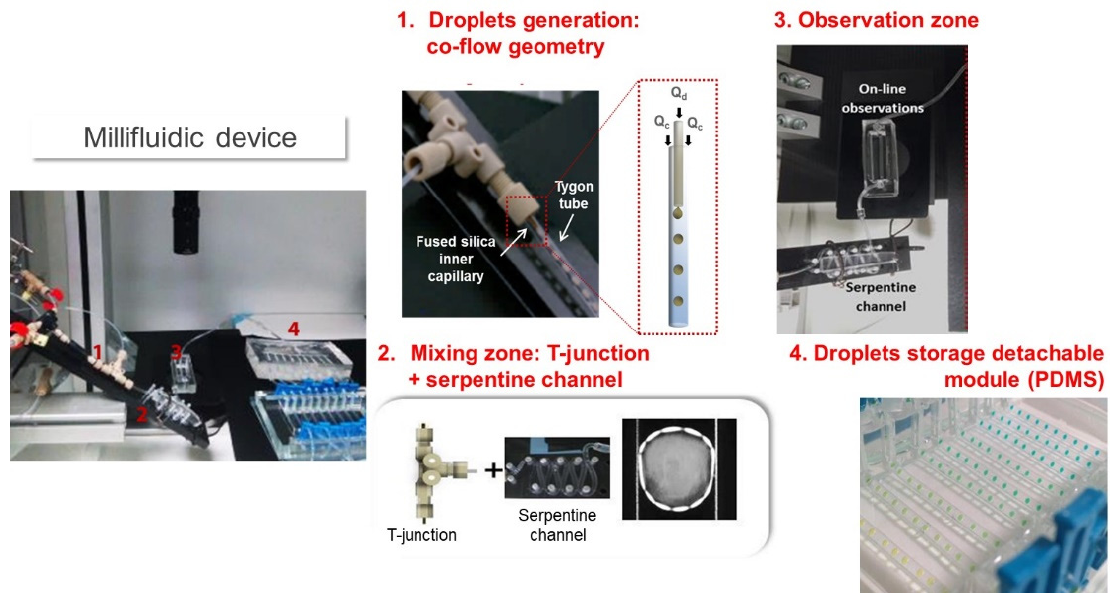
Figure 11. Droplet millifluidic devices developed to build biopolymers phase diagrams (adapted from [102] with permission from Springer).